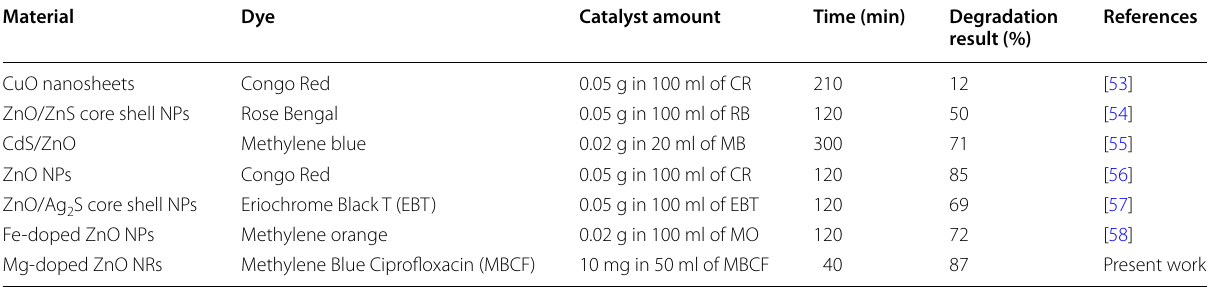
Table 2 Comparison table of photocatalysis efficiency of Mg‑doped ZnO nanorods with other reported materials Material Dye Catalyst amount Time (min) Degradation